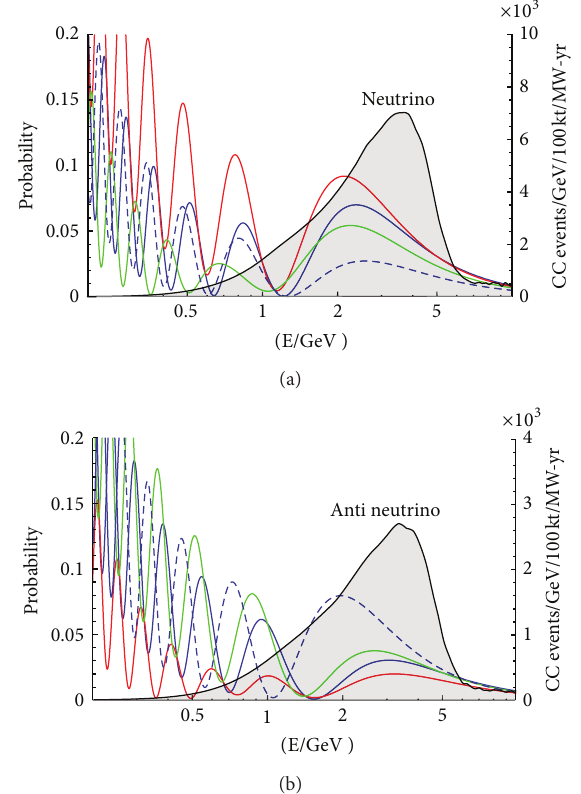
Figure2:Themuonchargedcurrenteventrateina100 ktdetectorat 1300km for neutrino (a) and antineutrino (b) running for the LBNE beam design with beam power of 700 kW and 2 × 10 7 sec (1 year of running) of running time. The event rate as a function of energy is superimposed on the expected 𝜈 𝜇 → 𝜈 𝑒 oscillation probability for 𝜃 13 = 9 ∘ . The various curves correspond to blue ( 𝛿 = 0 and inverted hierarchy), red ( 𝛿 dashed ( 𝛿 CP = −𝜋/2 ( 𝛿 CP